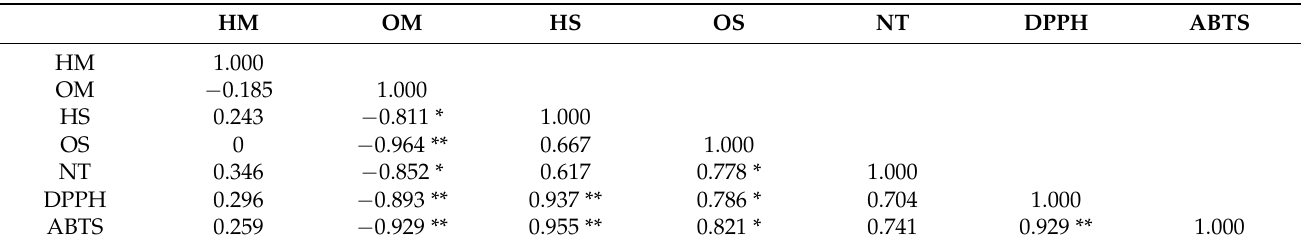
Table 4. Matrix of correlations between IC 50 DPPH and chemical composition of citral chemotype C. camphora and C. bodinieri .